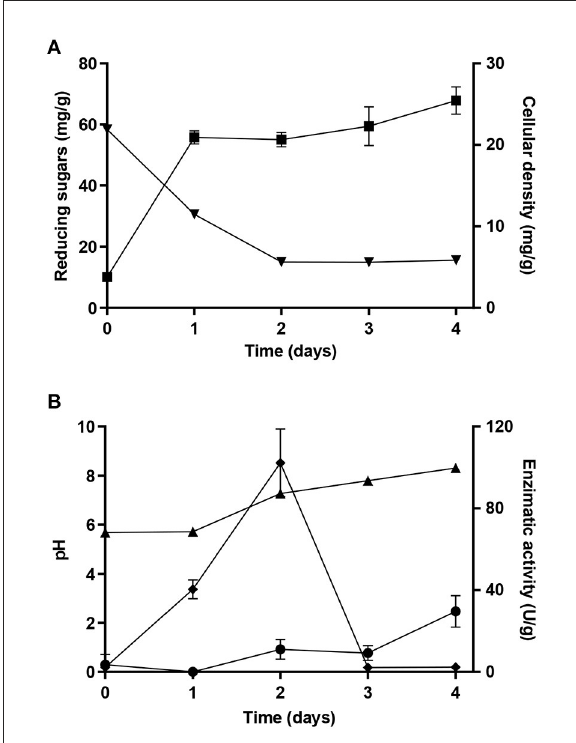
FIGURE3 (A) Cellular density ( (cid:4) ), reducing sugars concentration ( H ), (B) enzymatic activity of lipase ( (cid:7) ) and protease (•), and pH ( N ) obtained during SSF with Y. lipolytica W29 for 4 days with the optimum substrate mixture for lipase production.